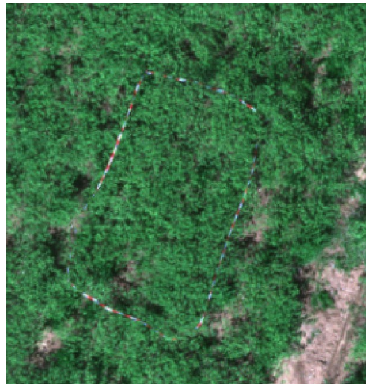
Figure 2. Example of a control zone set up in a parsley field marked with a ribbon to monitor maturity in UAV images according to ground truth harvested